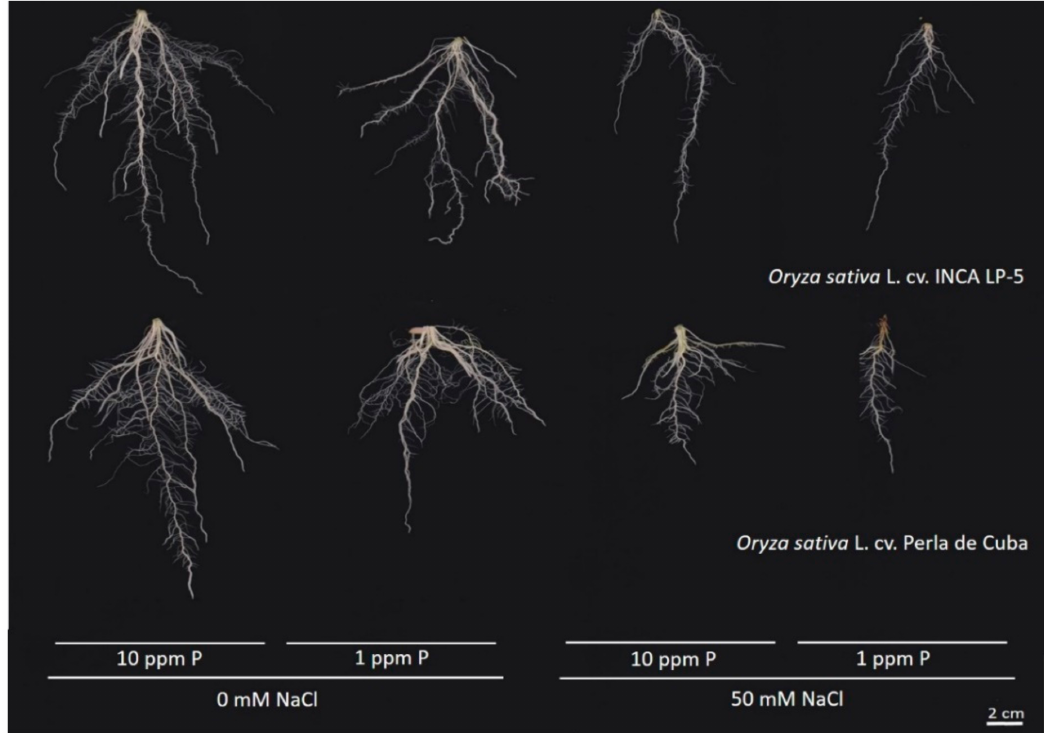
Figure 3. Representative root images of the two rice cultivars INCA LP-5 and Perla de Cuba after three weeks growth in mini-rhizotrons treated with low phosphorus (P), high salt (NaCl) or